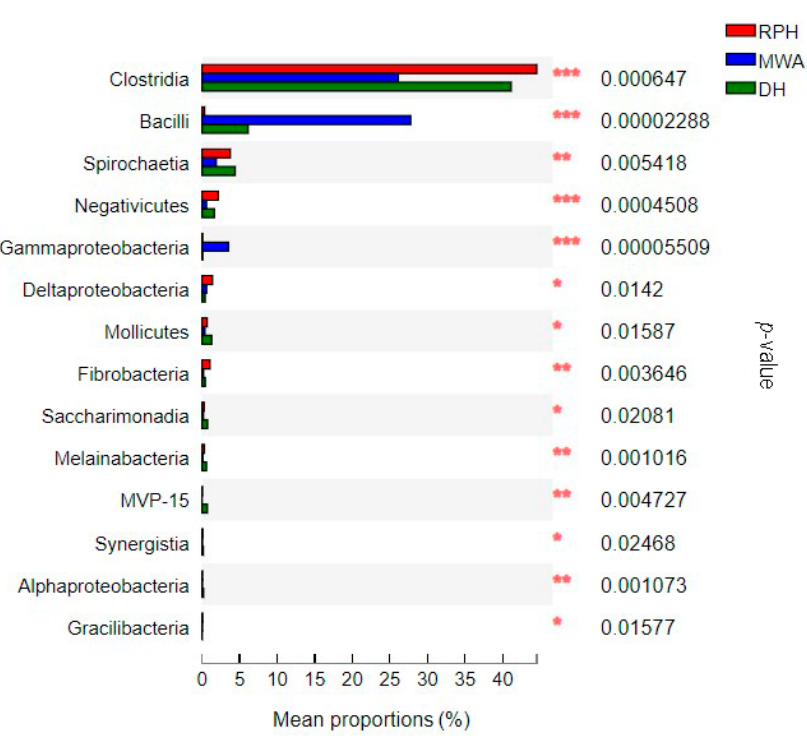
Figure 8. The bar plot shows the bacterial class with significant differences among RPH, DH and MWA. * p < 0.05, ** p < 0.01 and *** p < 0.001. The dominant orders in all samples were Clostridiales (CPHs: 60.46%; RPHs: 44.72%; DHs: 41.12%; MWAs: 25.80%) and Bacteroidales (CPHs: 18.47%; RPHs: 39.00%; DHs: 36.35%; MWAs: 30.19%), which belong to the classes of Clostridia and Bacteroidia , respectively. Six orders of Spirochaetales , WCHB1-41, Selenomonadales , Desulfovibrionales , Erysipelotrichales and Fibrobacterales had relative abundance at 0 order of magnitude in RPHs.